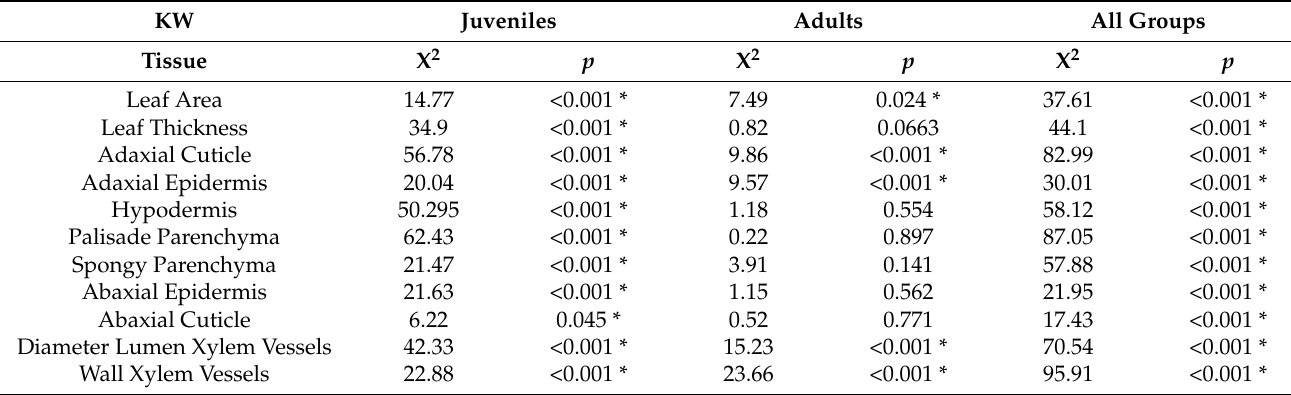
Table 1. Statistical results of morphoanatomical measurements in the leaf of juveniles and adults of R. mangle . KW: Kruskal Wallis. * = significant difference. df = 2 for intra-age comparisons and df = 5 for comparison of all groups. KW Juveniles Adults All Groups Tissue X